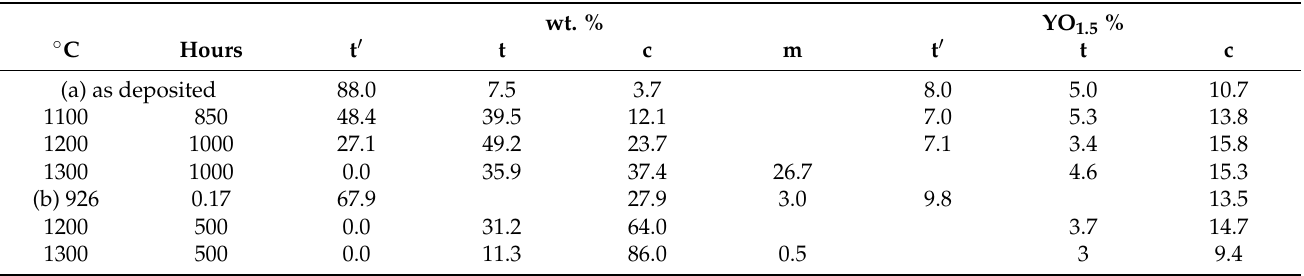
Table 1. Summary of YSZ-coating phases after various thermal aging treatments. Rietveld XRD full pattern fitting of for t (cid:48) , t, c, and m YSZ (wt. %), with corresponding compositions (YO 1.5 %): (a) from Witz et al., APS. [14] (b) this study, PS-PVD [5]. wt. % YO 1.5 % ◦